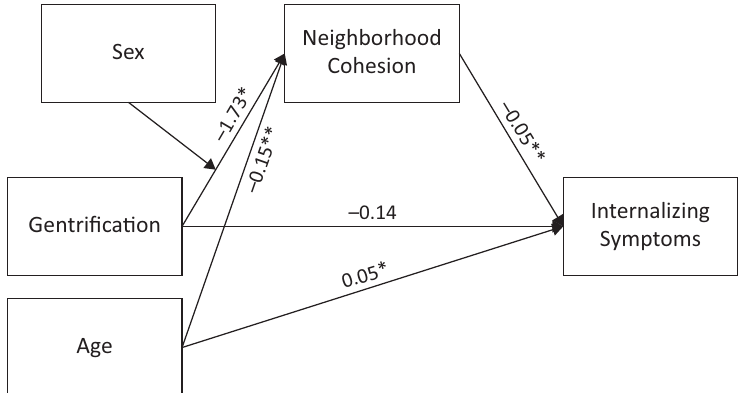
Figure 2. Model depicting mediation pathways linking gentrification, neighborhood cohesion, and internalizing symptoms. Note: *p < 0.05, **p <